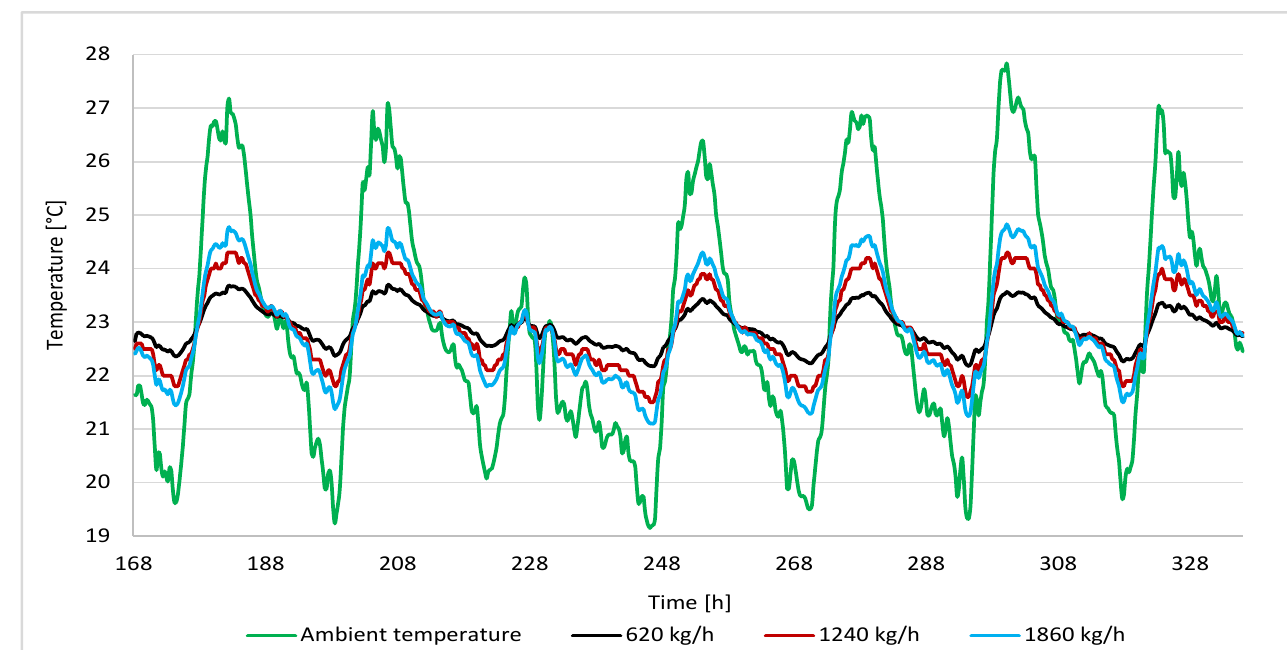
Figure 11. EAHE outlet air temperature vs air mass flow rate.